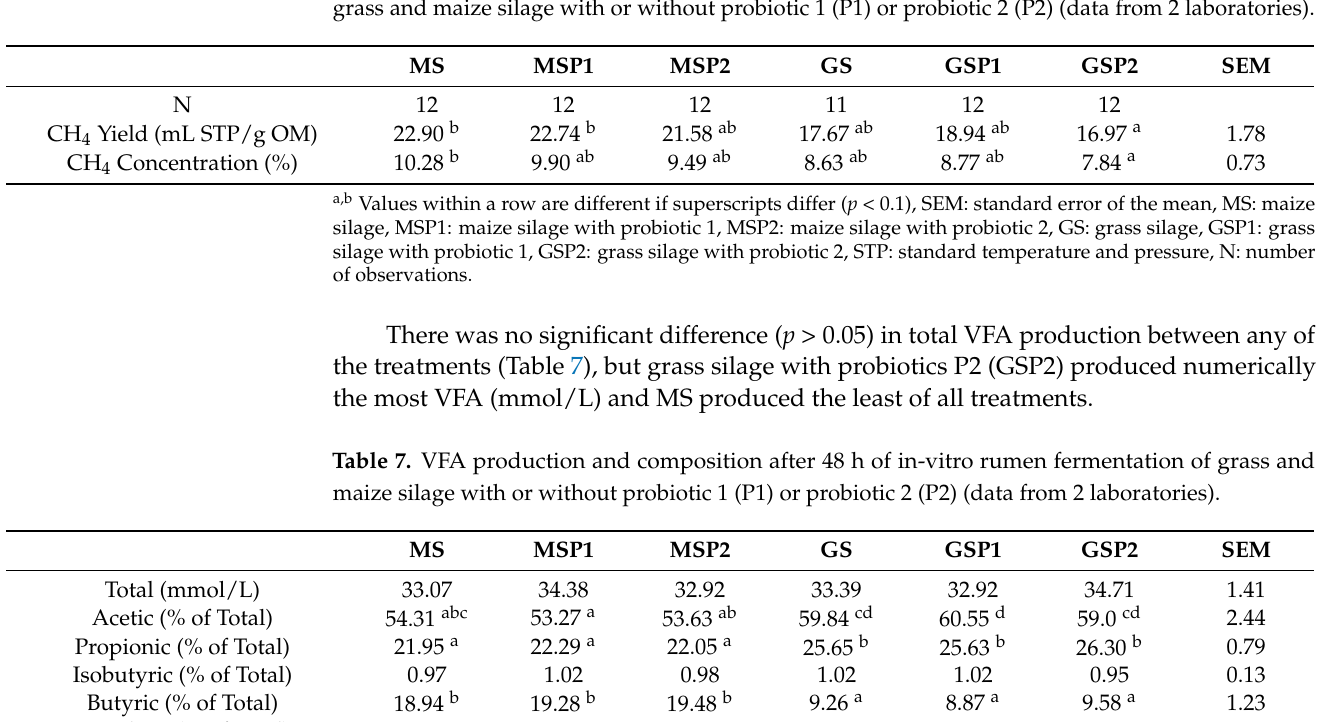
Table 6. Total CH 4 yield (ml STP/g OM) and concentration after 48 h in-vitro rumen fermentation of